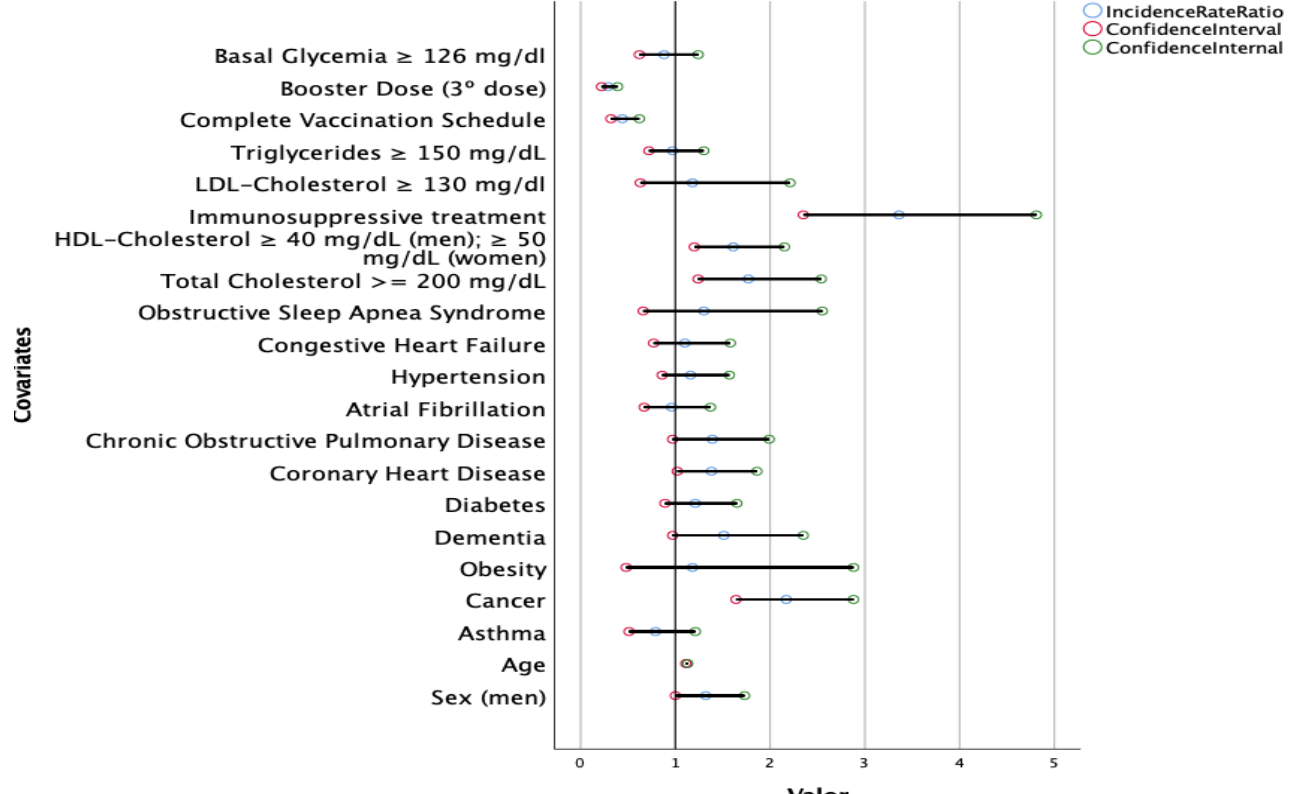
Figure 2. A multivariate Poisson regression model to explore the association between death according to sex, age, comorbidities, laboratory test results, immunosuppressive treatment and vaccination schedule in 110,726 SARS-CoV-2-positive patients admitted to hospital. p values of the variables of interest according to a variable permutation analysis: sex: 0.042; age: <0.001; asthma: 0.271; cancer: <0.001; obesity: 0.720; dementia: 0.069; diabetes: 0.230; coronary heart disease: 0.036; chronic obstructive pulmonary disease: 0.071; atrial fibrillation: 0.829; hypertension: 0,327; congestive heart failure: 0,587; obstructive sleep apnea syndrome: 0.447; total cholesterol: 0.002; HDL-cholesterol: 0.002; immunosuppressive treatment: <0,001; LDL-cholesterol: 0.609; triglycerides: 0.818; complete vaccination schedule: <0.001; booster dose: <0.001; fasting glucose levels: 0.450.